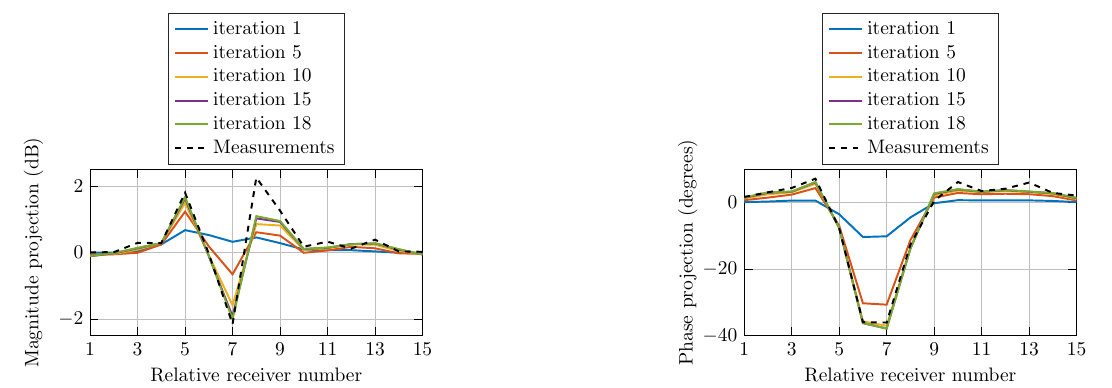
Figure 12. Comparison of calculated magnitude and phase projections of the signals transmitted from Antenna 1 for multiple iterations as a function of receiver number. The actual measurement projection is also